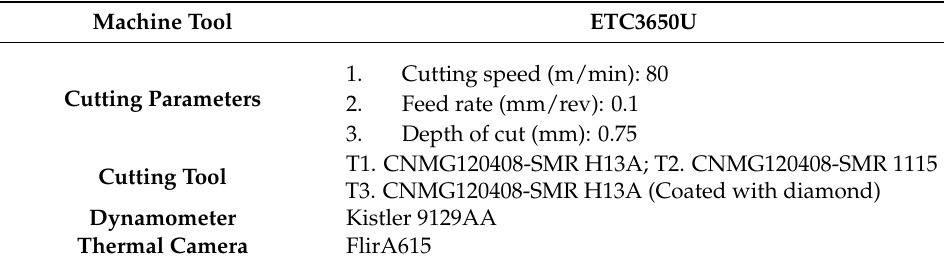
Table 3. Experimental specifications.